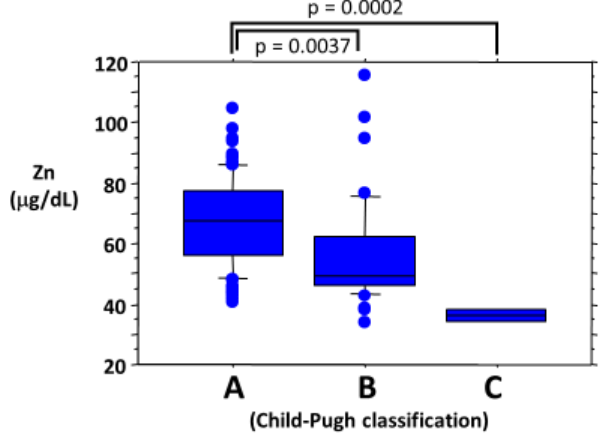
Figure 6. Relationship between serum zinc levels and Child–Pugh classification. A, Child-Pugh class A; B, Child-Pugh class B.; C, Child-Pugh class C.